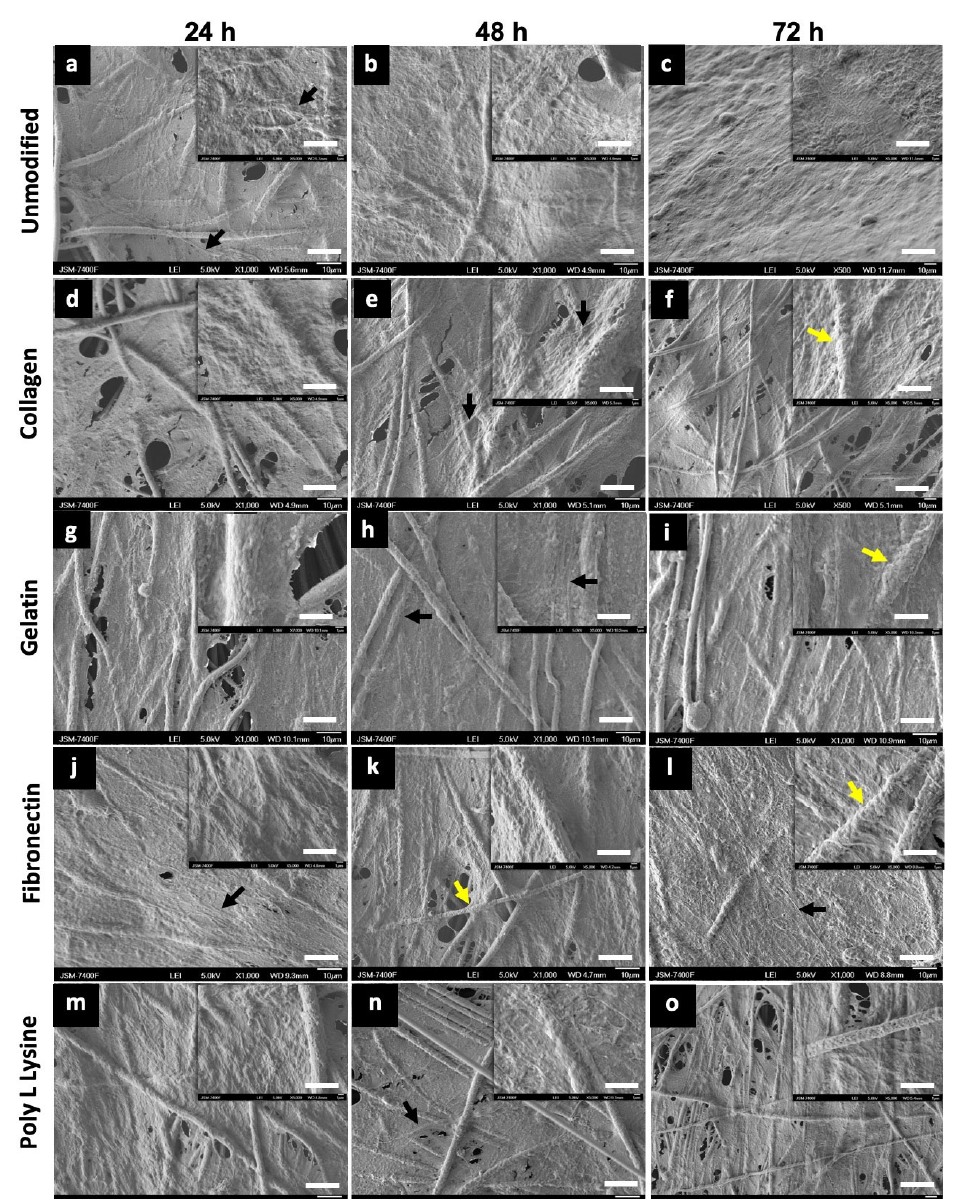
Figure 8. Scanning electron microscope (SEM) images of AHCF cultured on unmodified PLLA and protein modified fibers (scale bar=10 μ m). Adult human cardiac fibroblasts (AHCF) cells can be